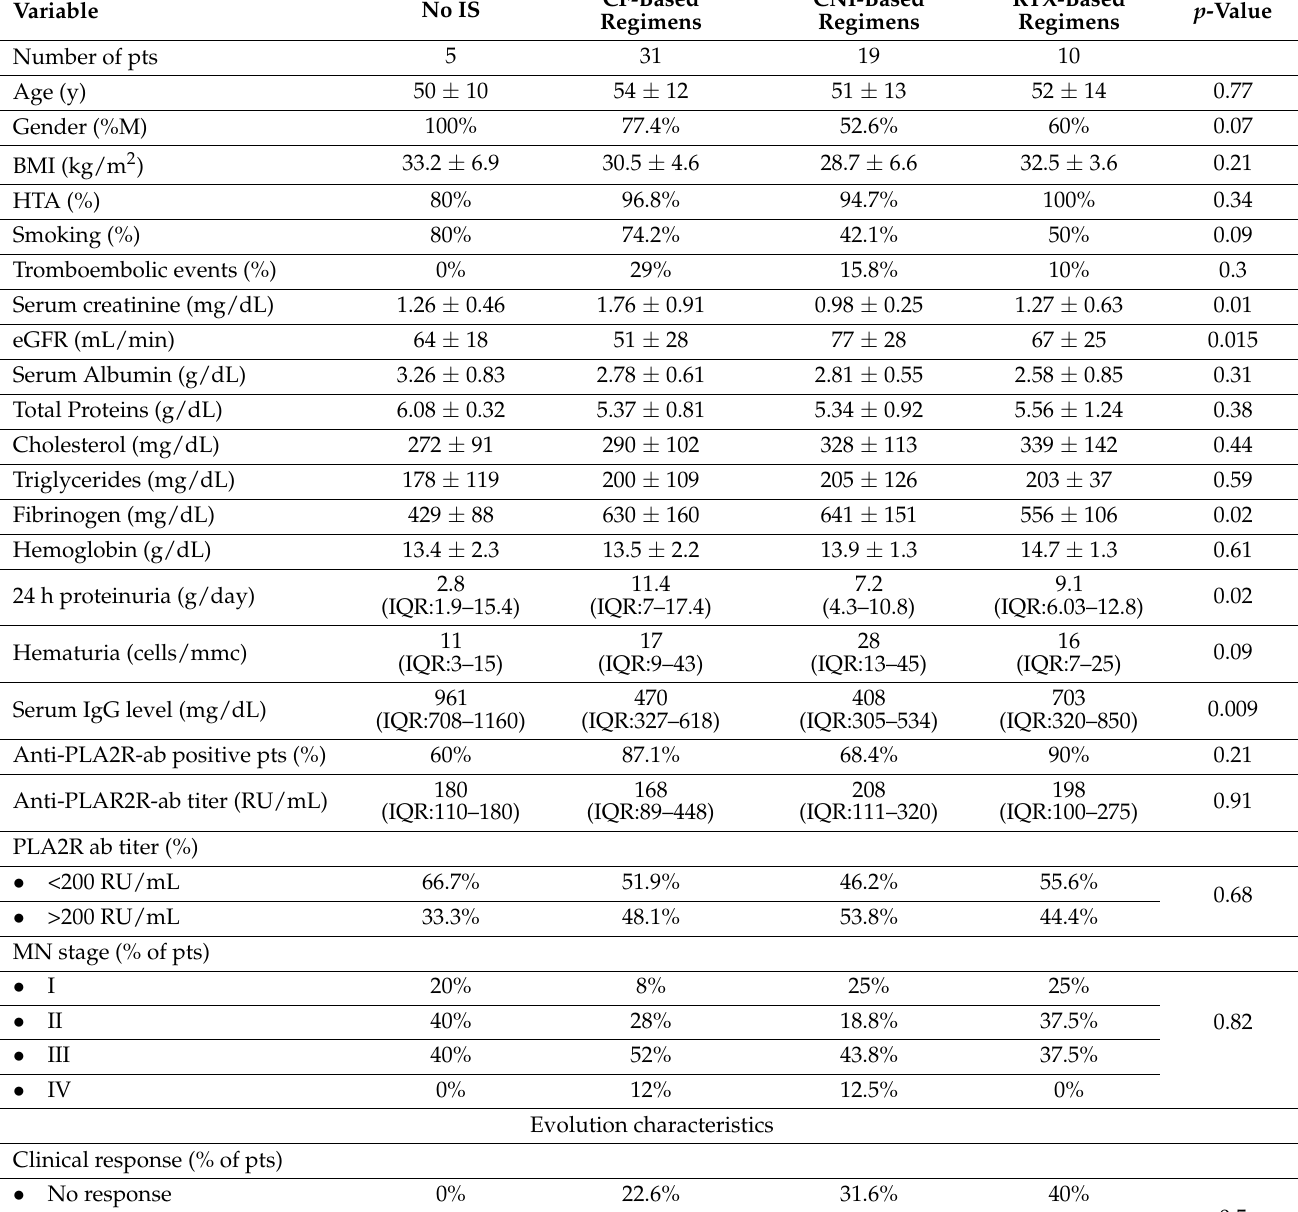
Table 4. Univariate analysis according to immunosuppressive